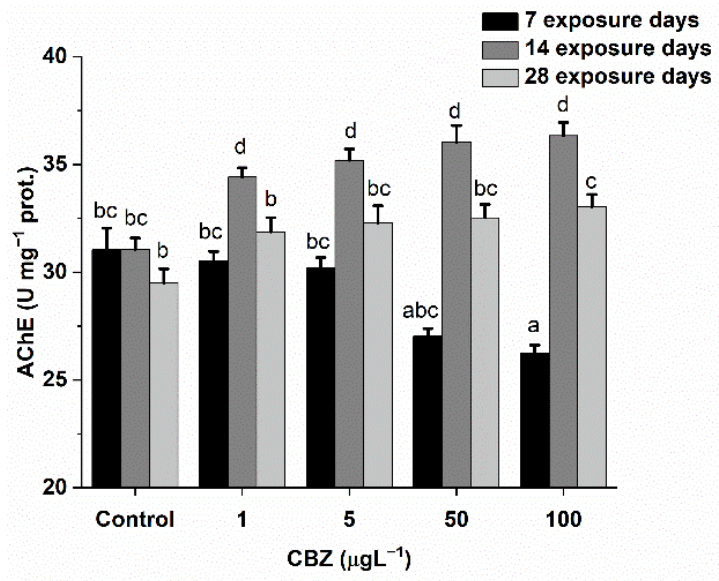
Figure 1. Changes in AChE activity in the brain of Cyprinus carpio exposed to CBZ for 7, 14, and 28 d. Data are expressed as mean ± standard deviation of three replicates ( n = 3). Different letters designate significant differences at p < 0.05 after a two-way ANOVA followed by Tukey’s post-hoc test.